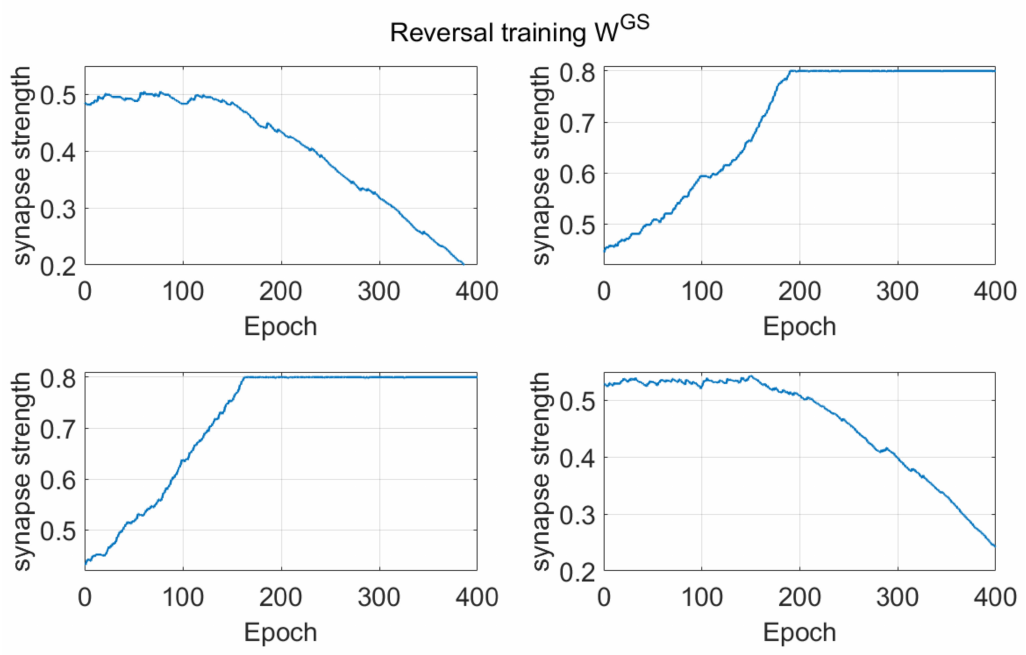
Figure 7. Effect of reversal learning on the sensory synapses. The figure shows the temporal pattern of the synapses which connect the external stimulus S to the Go neurons, as a function of the reversal training epoch (rule post-post) performed after a previous 50 epochs basic training. The meaning is the same as in Figure 3, but now the first channel responds to the second stimulus and the second channel to the first one. Hence, the synapse strength increases in the secondary diagonal of the synapse array, and decreases on the principal diagonal, by inverting the initial